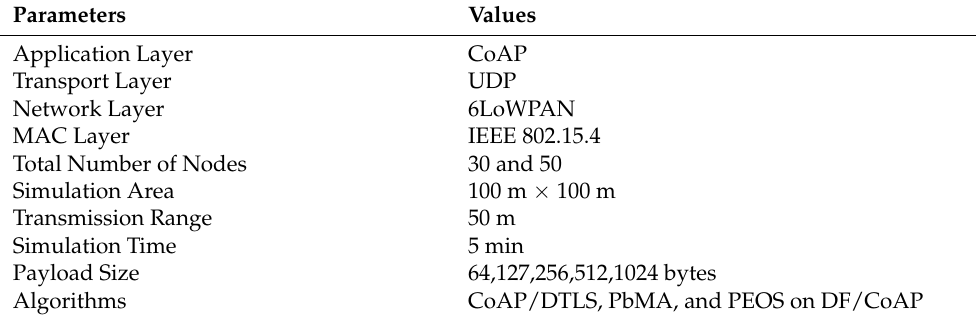
Figure 6. Experiment scenarios based on Contiki OS. ( a ) Network design diagram for 30 nodes; ( b ) Network design diagram for 50 nodes. Table 1. Experimental parameters.